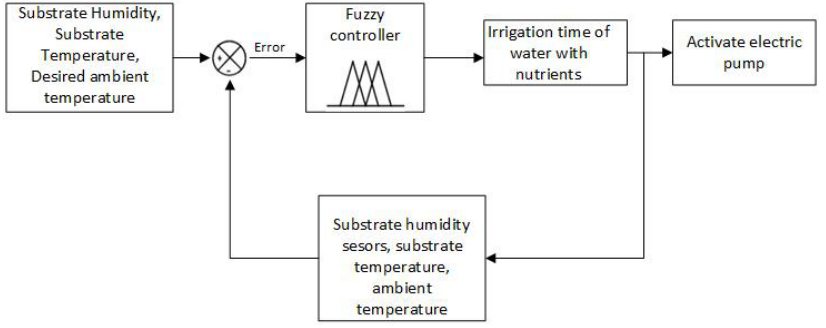
Figure 10. Fuzzy controller 1.